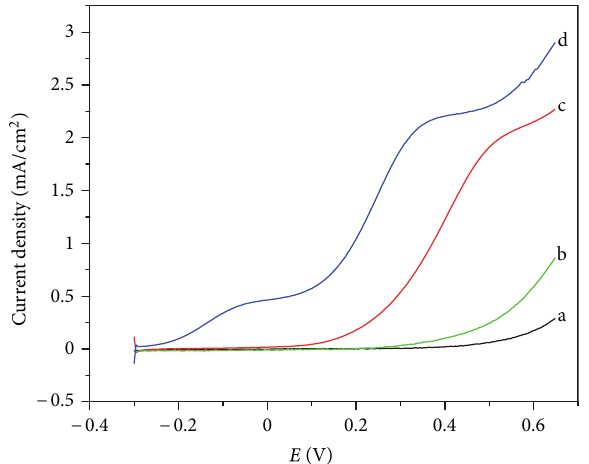
F 7: Linear oxidative desorption of 1mM aqueous solution of cysteineinabufferpH=7on(a)bareAu,(b)AuNPs,(c)C and (d) C DTC/AuNPs/Au electrodes. Scan rate = 50